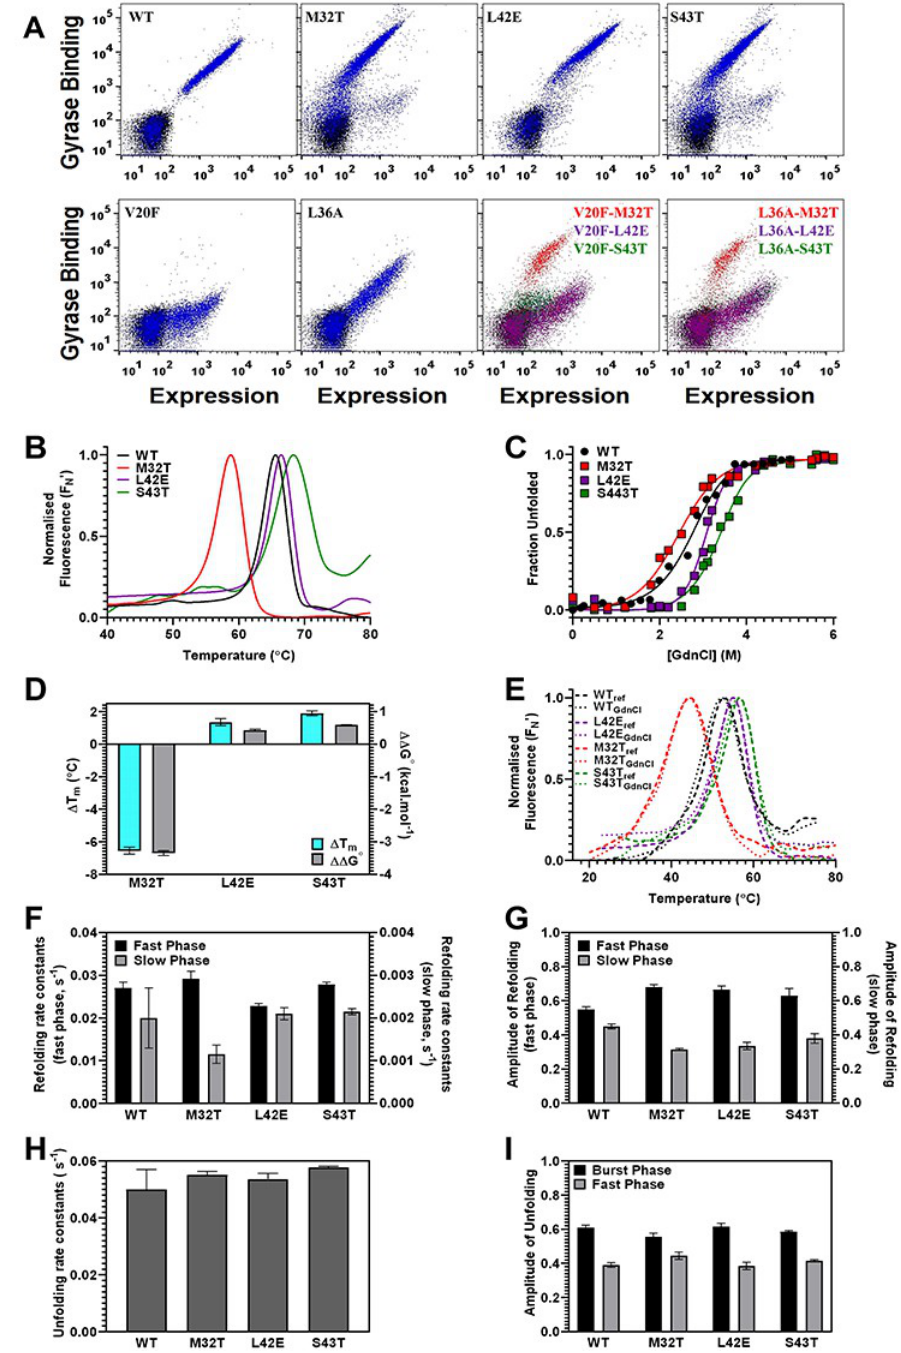
Fig 7. Enhanced stability is neither necessary nor sufficient for a mutant to act as a global suppressor. (A) Analysis of yeast cell surface expression and GyrA14 binding of different CcdB mutants and WT. CcdB WT and mutant plots (blue), are overlaid with plot of uninduced cells (black). In the last two panels, V20F-M32T, L36A-M32T plots (red) are overlaid with plots of V20F-L42E, L36A-L42E (purple) and V20F-S43T, L36A-S43T (green), only M32T is able to suppress the deleterious effects of the V20F and L36A mutations. (B-I) Kinetic and thermodynamic characterisation of CcdB mutants. (B) Thermal unfolding profiles of 5 μ M of CcdB-WT, M32T, L42E and S43T mutants carried out by nanoDSF. (C) Equilibrium GdnCl denaturation profiles of 5 μ M of CcdB-WT, M32T, L42E and S43T mutants carried out by nanoDSF. (D) Difference in thermal Δ T m ð D T ¼ T (cid:0) T Þ (in cyan), and thermodynamic stability m m Mutant m WT assayed by chemical denaturation, ΔΔ G˚ ð DD G � ¼ D G � (cid:0) D G � Þ (in grey) of the CcdB mutants. (E) Mutant WT